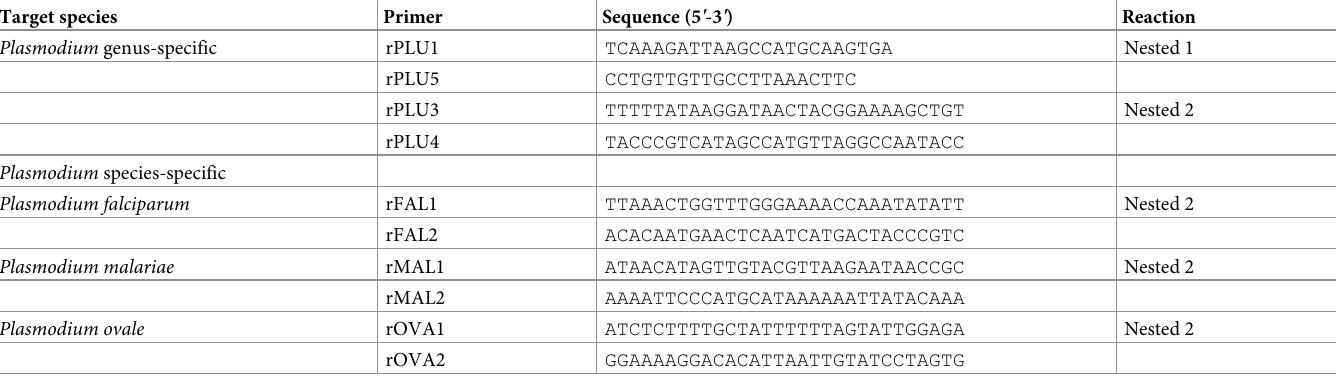
Table 1. Nested PCR protocol and Plasmodium ssrRNA genes used in this study. Target